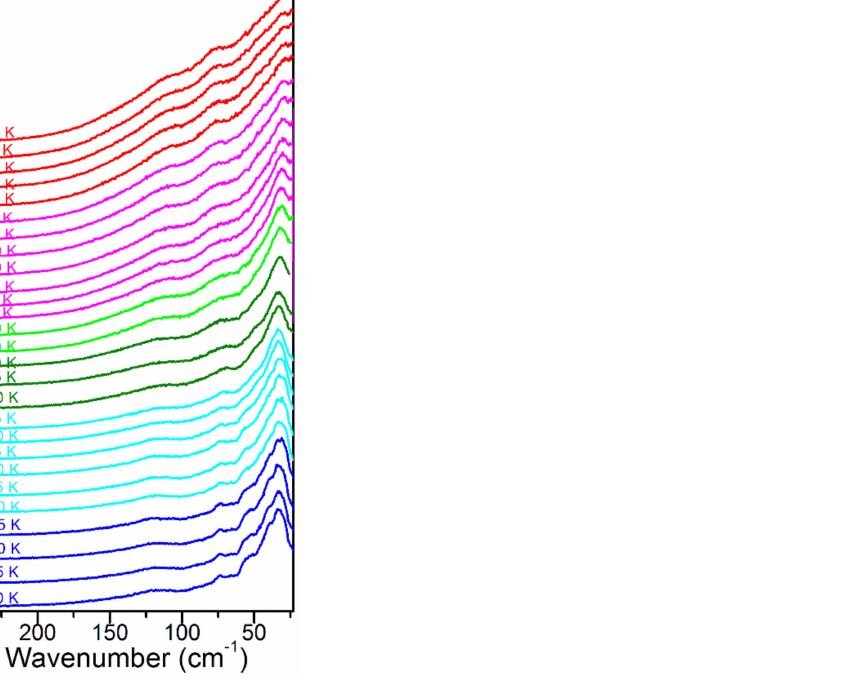
Figure 6. Temperature-dependent Raman spectra of FAPbBr 3 in the 250–22 cm − 1 range. Red colour corresponds to the Pm 3 m phase; magenta, green and dark green colours correspond to the P 4 /mbm phase; and cyan and blue to the Pnma phase.